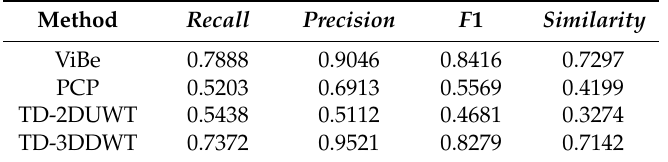
Table 15. Comparison of category-average metrics for the baseline category 1